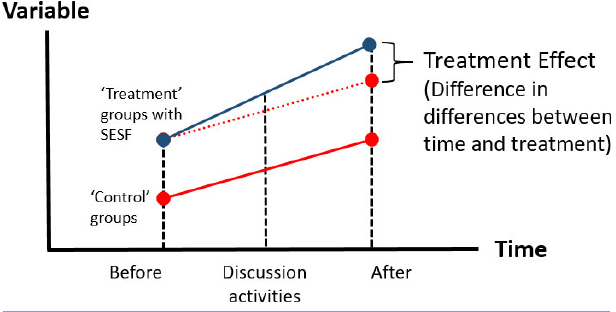
Fig. 2 . Graphical representation of analyzing controlled experiments via before-after control-impact or difference in differences. SESF = social-ecological system